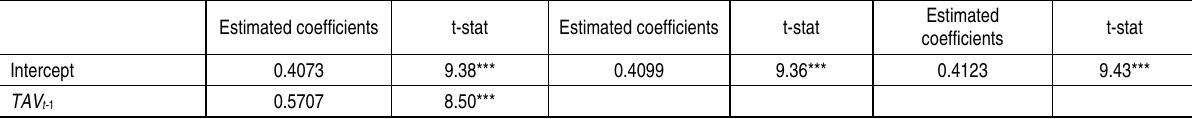
Table 4. Regression results on Hypothesis